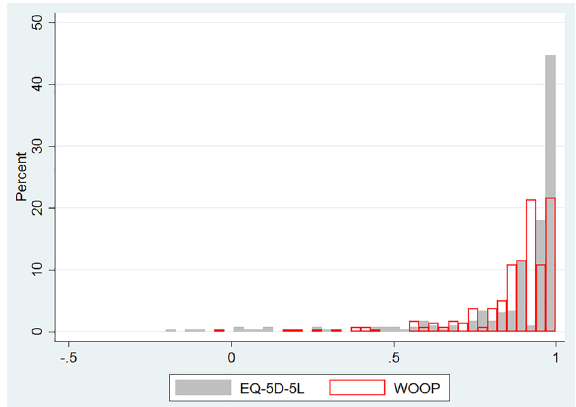
Figure 2. Utility distributions of EQ-5D-5L and WOOP.